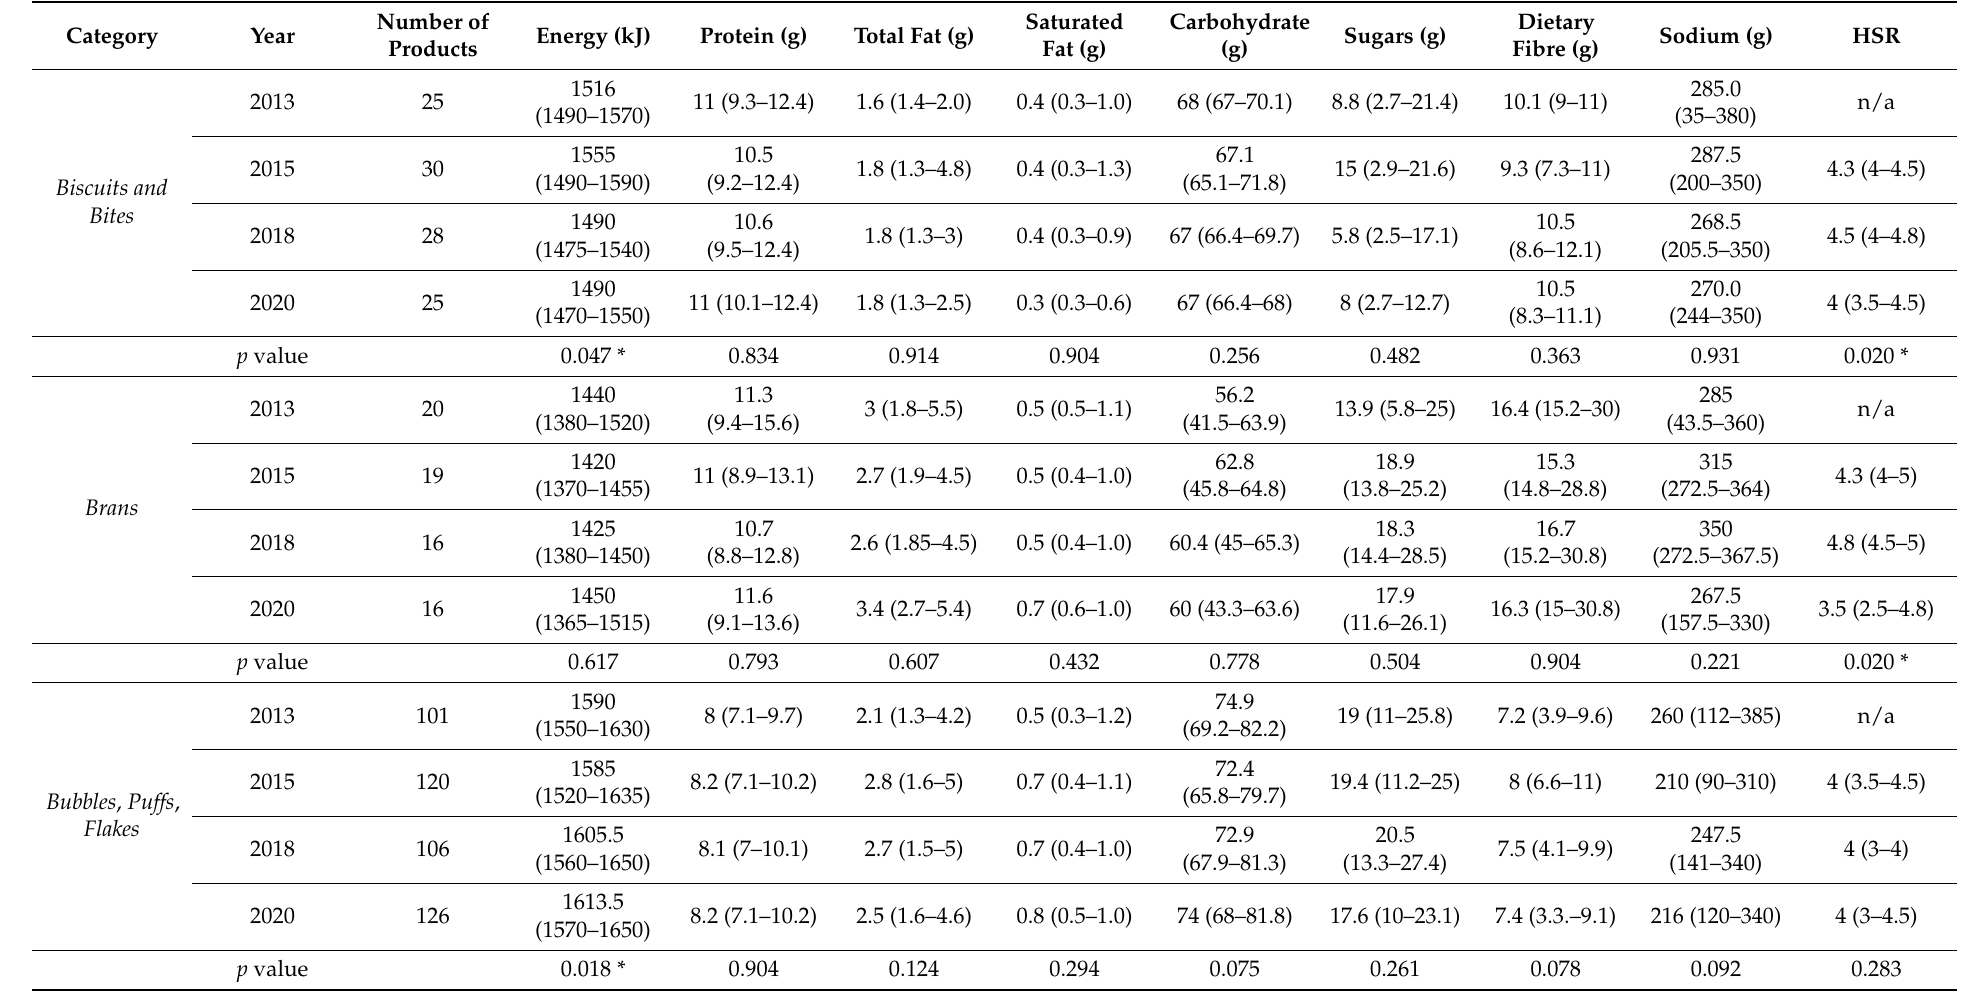
Table 2. Nutrient comparison and Health Star Rating (HSR) per 100 g of breakfast cereals between 2013, 2015, 2018, and 2020 (median ±